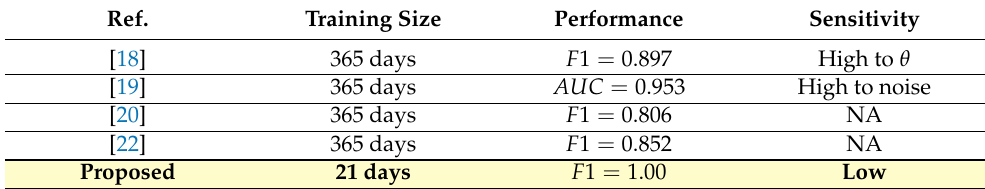
Table 6. Comparison with other